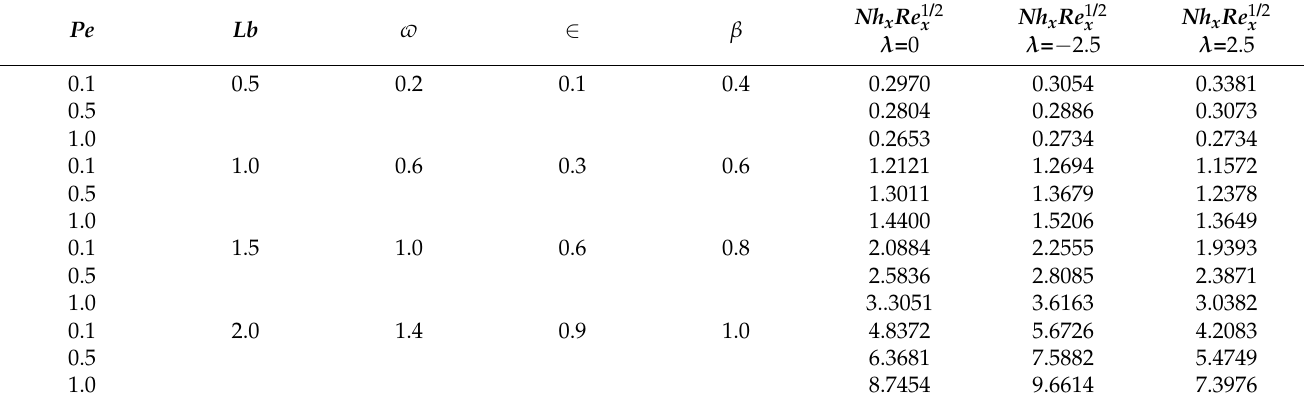
Table 5. Motile density microorganisms for various physical